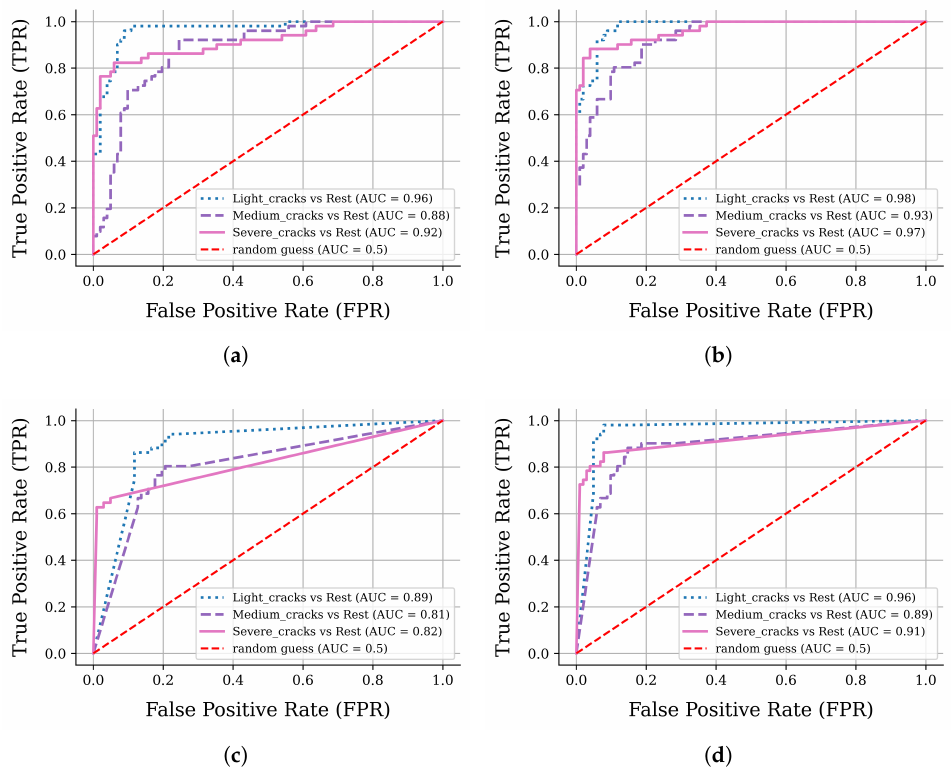
Figure 14. ROC for ( a ) VGG16-ANN, ( b ) ResNet50-ANN, ( c ) VGG16-kNN, ( d ) ResNet50-kNN model trained with greyscale images